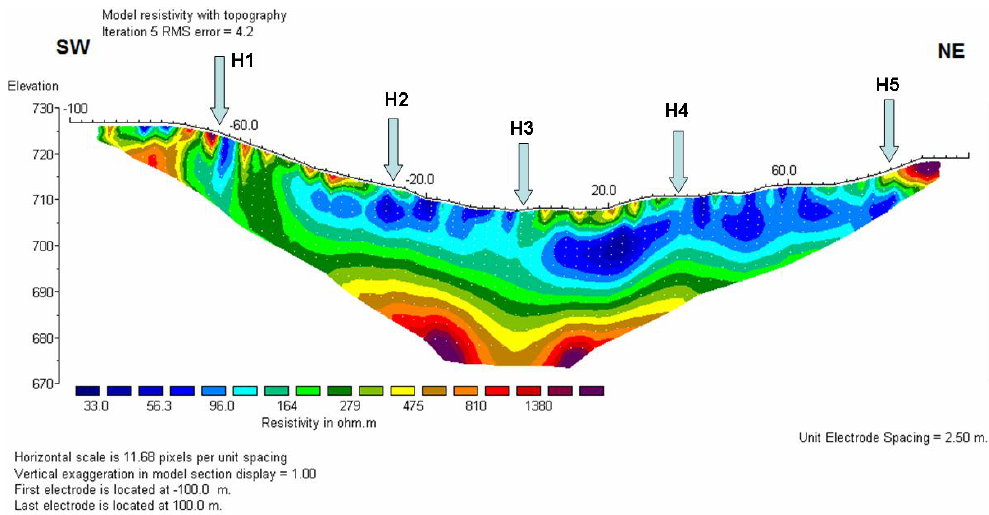
Fig. 5. ERI pseudosection of Transect 1 (hillslope-wetland-hillslope) (Schlumberger short).